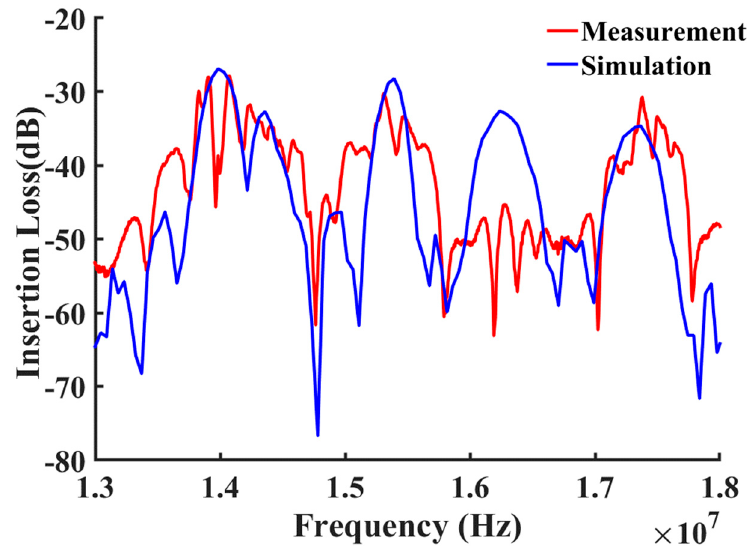
Figure 5. Comparison between simulated and measured frequency responses for the device (with 100 nm Cr IDTs only) from 12 MHz to 18 MHz.